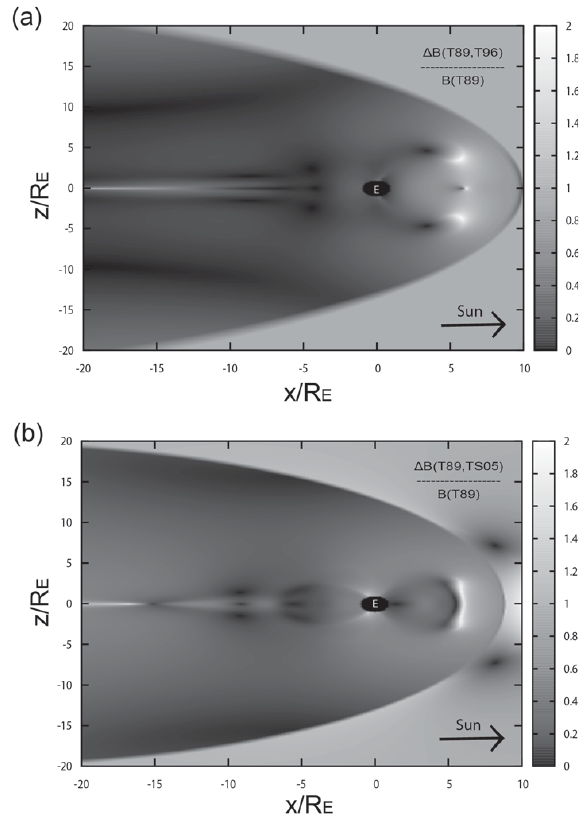
Figure 2. Computation of the relative deviation between the com- putations of the geomagnetic field, for zero tilt angle in a dis- turbed magnetosphere (Kp = 5 and Dst = − 70nT), using the mod- els (a) T89 and T96 and (b) T89 and